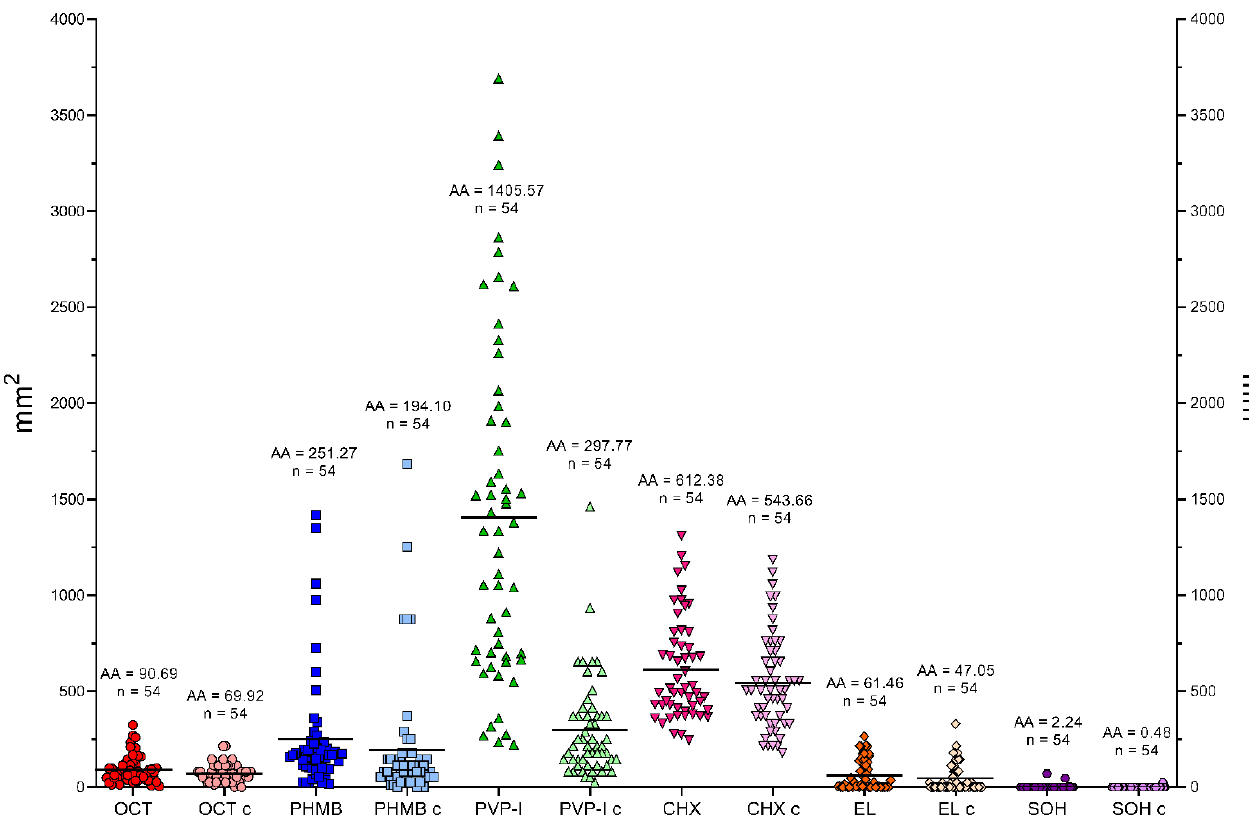
Figure 13. Distribution of average areas of growth inhibition zones (mm 2 ). For every compound, there are 2 kinds of probes: chemisorbed BC dressings (OCT — octenidine dihydrochloride, PHMB — polyhexanide, PVP-I — povidone-iodine, CHX — chlorhexidine, EL — ethacridine lactate, SOH — super-oxidized hypochlorites solution) and soaked blotting paper discs compounds as a compound activity control (OCT c — control of OCT activity, PHMB c — control of PHMB activity, PVP-I c — control of PVP-I activity, CHX c — control of CHX activity, EL c — control of EL activity, SOH c — control of SOH activity). AA — arithmetic average of growth inhibition zones areas (black lines), n — number of tested strains (54).